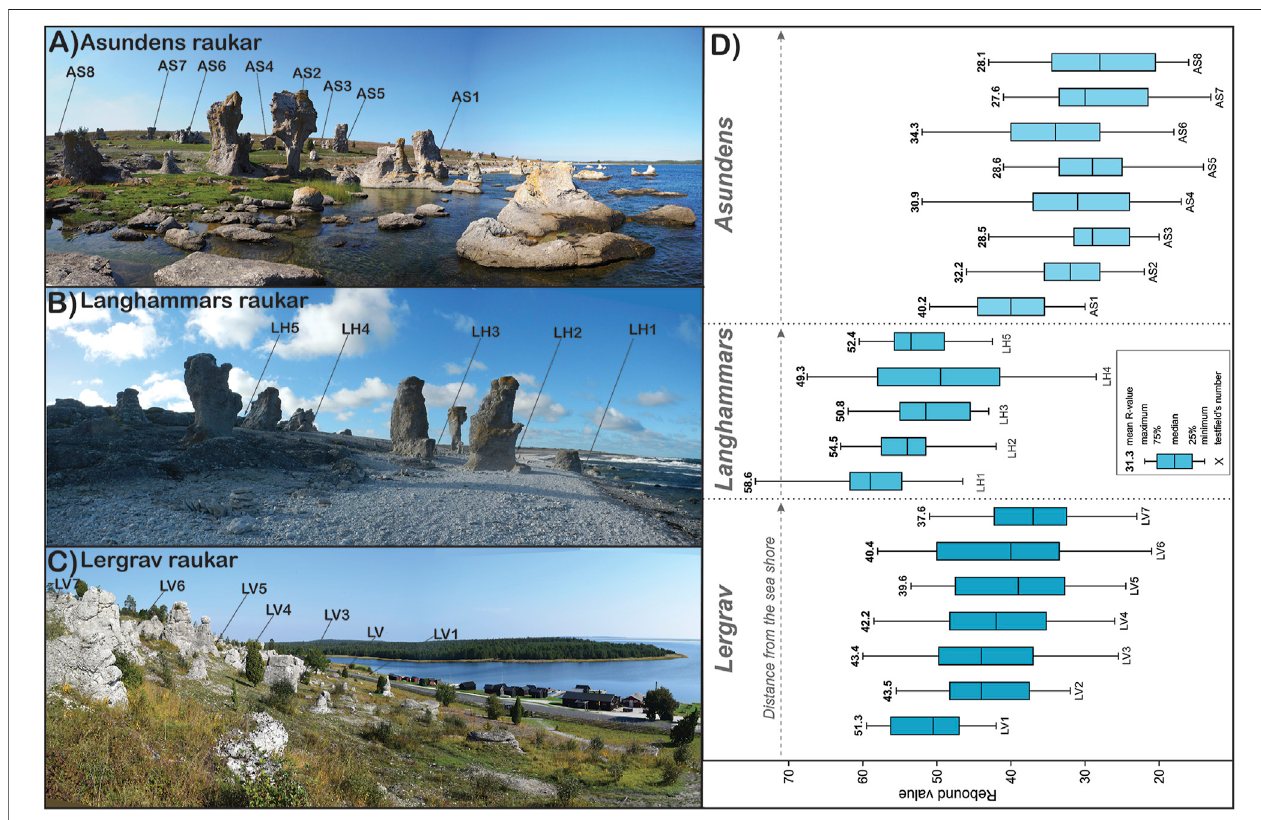
FIGURE 4 | The results of Schmidt hammer rock tests across the rauk fi elds at (A) Lergrav, (B) Langhammars, and (C) Asundens. (D) Box plots showing the variability of rock hardness across the test sites. The exact location of the tested surfaces at each rauk fi eld is shown at (A – C) .